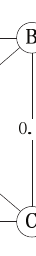
Fig. 2. The initial undirected adjacency